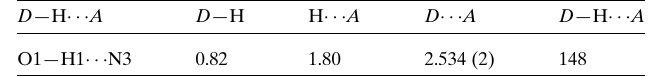
Table 2 Experimental details.